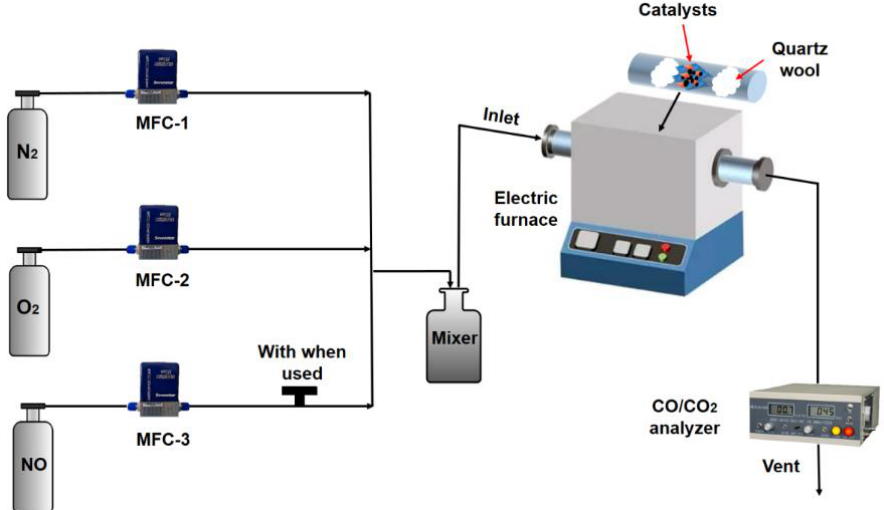
Figure 1. Schematic diagram of the experimental setup.